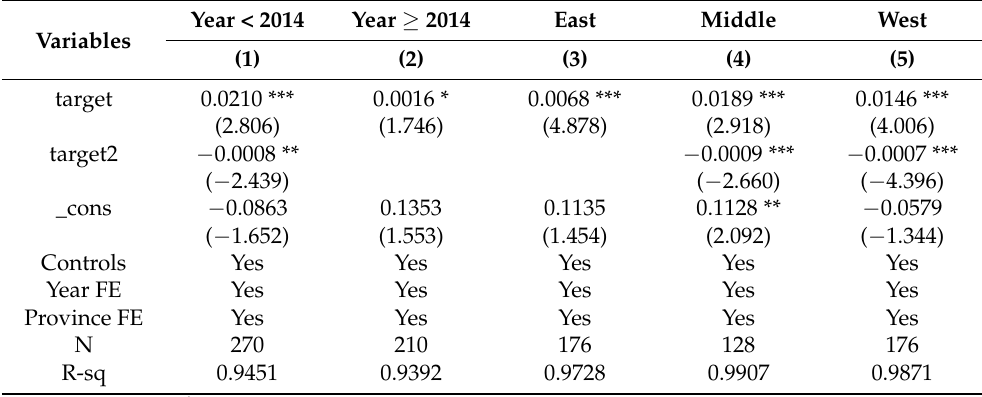
Table 7. Regional and time